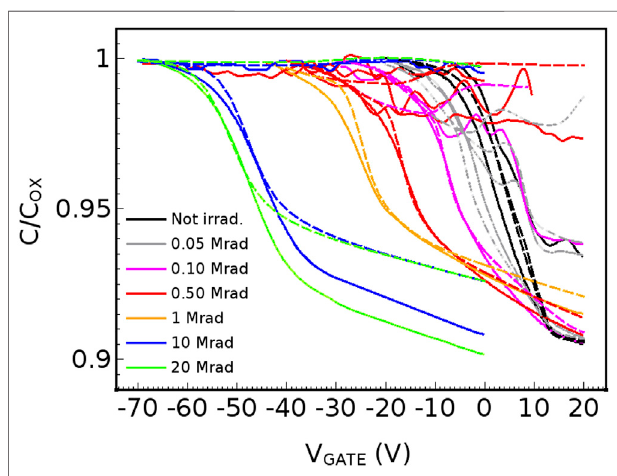
FIGURE 11 | C-V characteristics of FBK p-type MOS capacitors and after X-ray doses of 0.05, 0.10, 0.50, 1, 10, 20 Mrad(SiO 2 ): comparison between measurements (solid lines) and simulations (dashed lines).